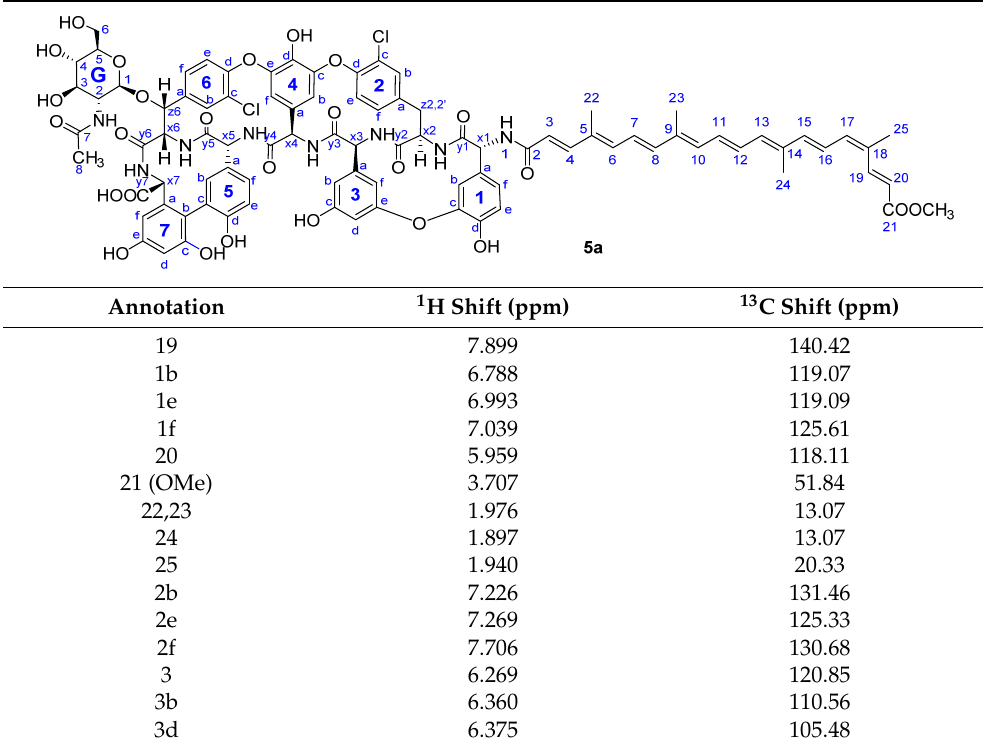
Table 4. NMR data of 5a .